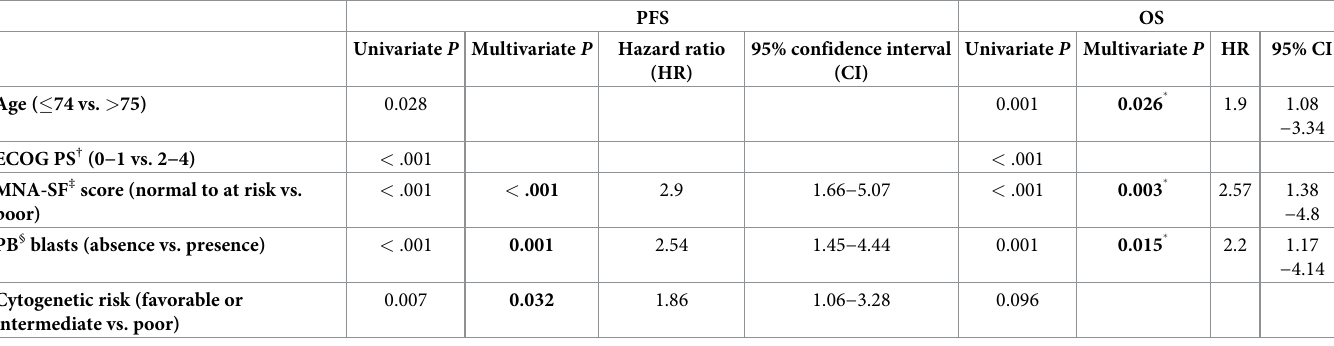
Table 4. Multivariate analysis for Progression-Free Survival (PFS) and Overall Survival